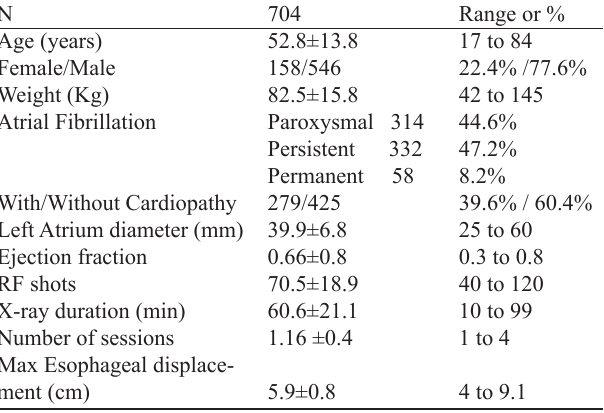
Table 1. Main features of 704 patients included in this